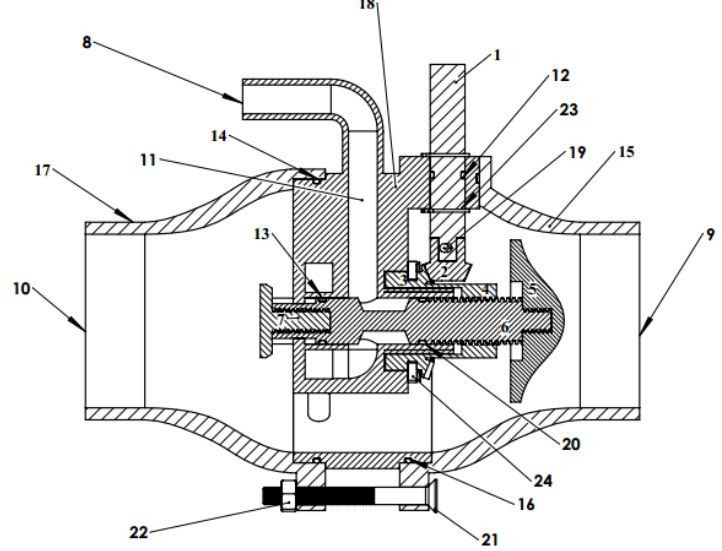
Figure 1. New mixer parts:(1) Shaft connect with stepper motor; (2) Small bevel gear; (3) Large bevel gear; (4)Large nut; (5) Valve head; (6) Valve body; (7) Valve screw; (8) Fuel inlet; (9) Air inlet; (10) Mixing outlet; (11) Fuel manifold; ( 12,13,14,16 and 20) O- rings; (15 and 17) Covers; (18) Main body; (19) Groove pin; (21) Bolt; (22) Nut; (23 and 24) Retaining rings (circlip).